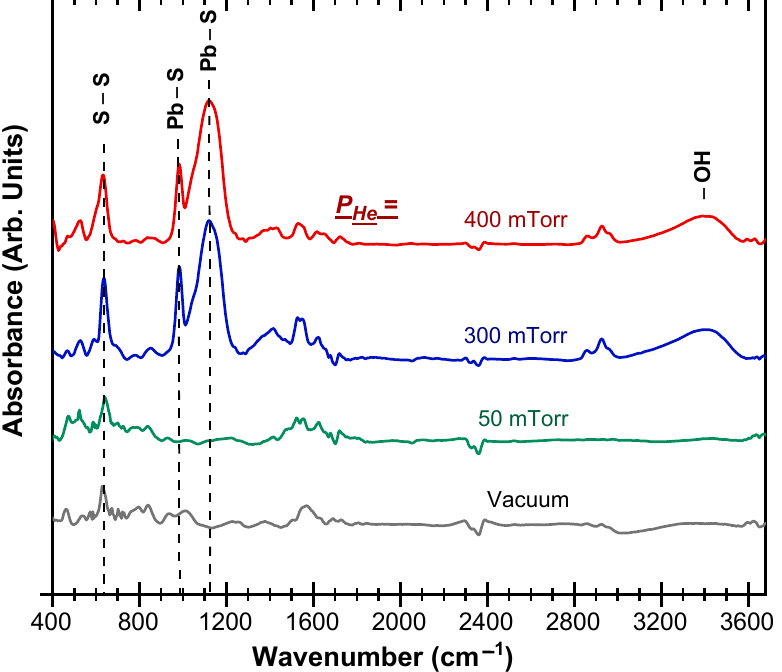
Figure 4. FTIR spectra of the PbS films pulsed-laser-deposited on silicon substrates under vacuum and selected He background pressures (50, 300, and 400 mTorr).